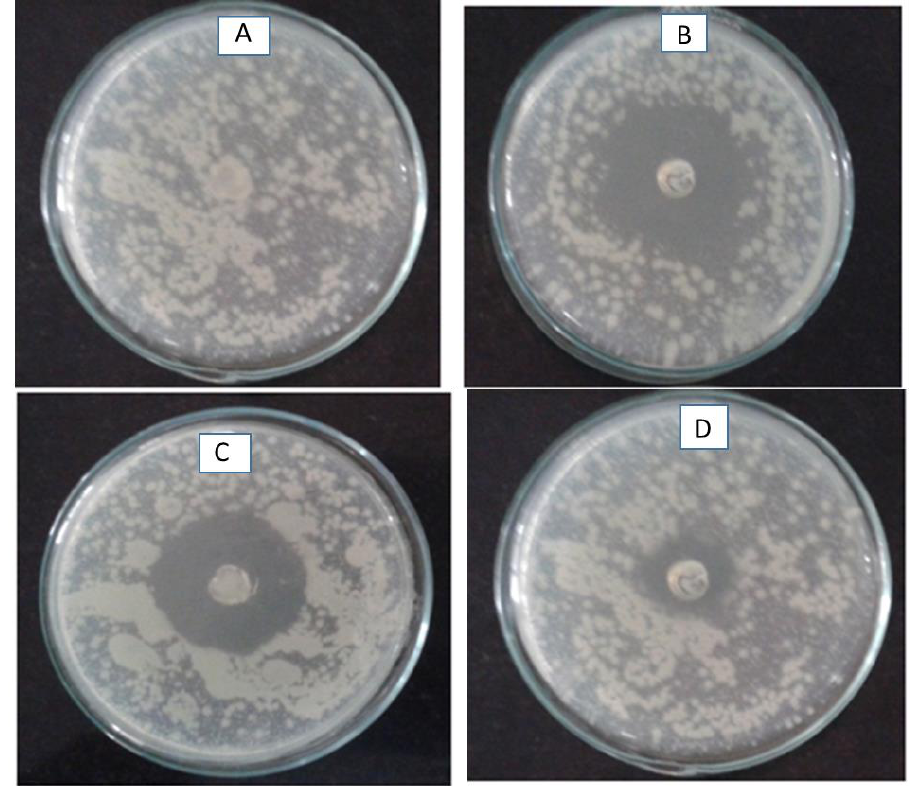
Figure 3. Anti-microbial studies of ( A ) Placebo ( B ) Nanocarrier formulation (F1) in Staphylococcus aureus species ( C ) Nanocarrier formulation (F1) in Escherichia coli species. ( D ) Plain gel loaded with ciprofloxacin